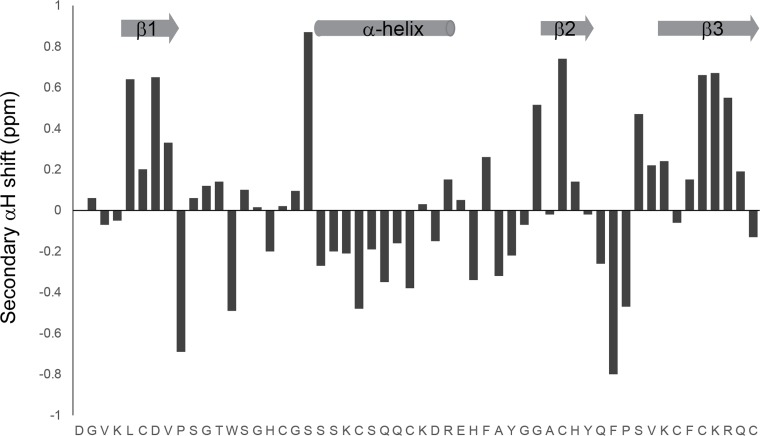
Secondary shift analysis of rHsAFP1, pH 4.0 at 298 K.Regions of α-helix and β-strand are indicated at the top of the figure.